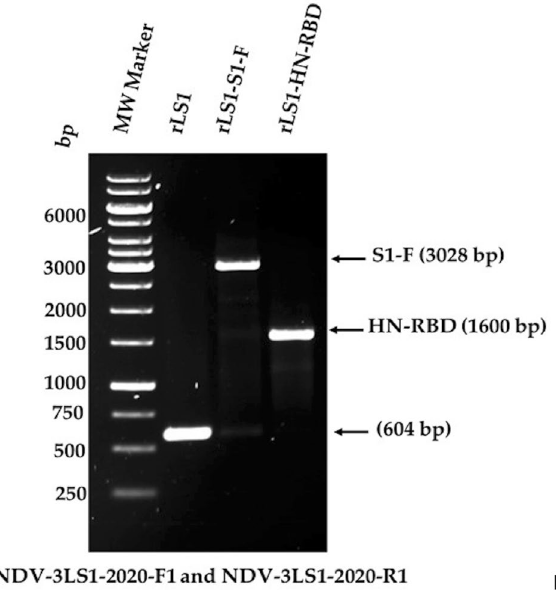
Figure 1. The insertion of the expression cassette into the non-coding region between the P/M genes of NDV genome was verified by RT-PCR using the primers NDV-3LS1-2020-F1 and